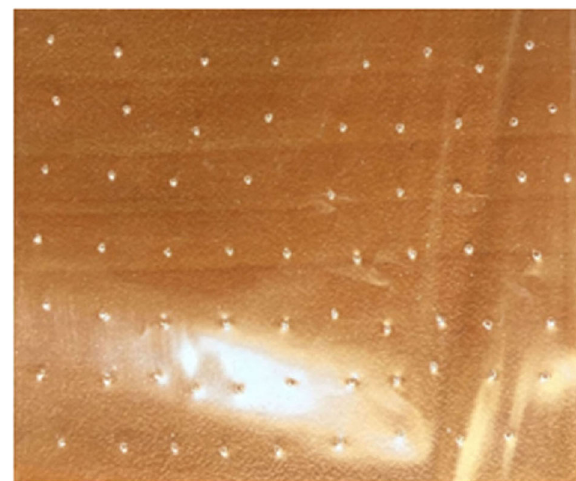
Fig. 8 Relationship between surface tension and the amount of collected water. An increase of silicon % in the structure up to a certain level indicates an increase in fumed silica. There is also a relation such as surface tension = 5.0648 (deposition water) − 0.452, although it is not a very compatible graphic.